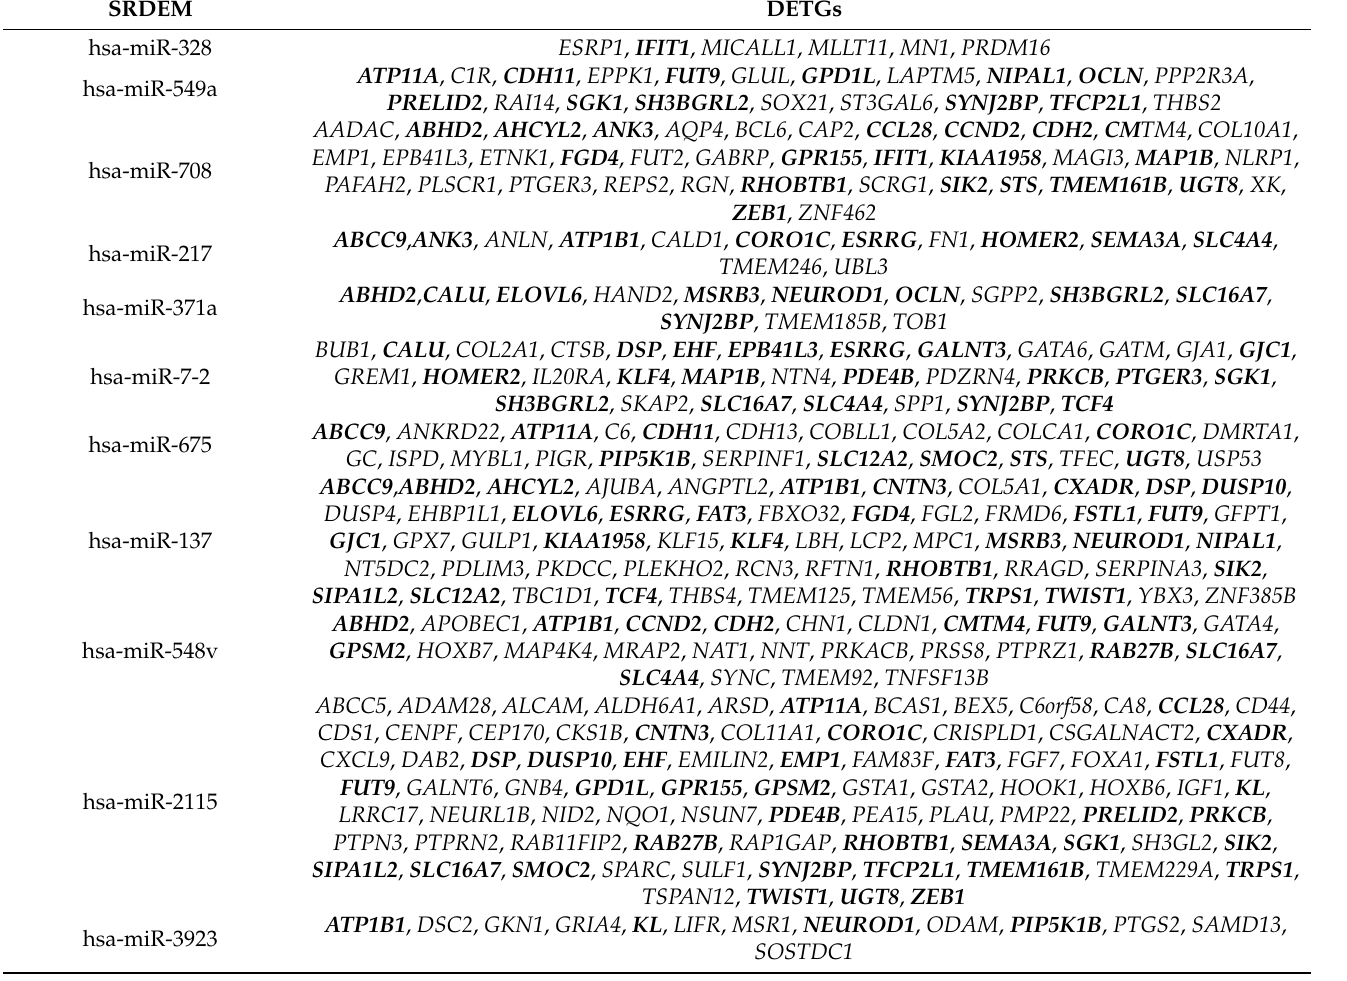
Table 2. Two hundred thirty-three DETGs shared by DEGs and the target genes of 11 SRDEMs. SRDEM